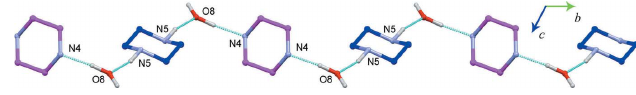
Figure 4 Part of the crystal structure of (I) showing the molecular chain, formed by O8–H8 C (cid:3)(cid:3)(cid:3) N4 and N5—H5 A (cid:3)(cid:3)(cid:3) O8 hydrogen bonds, which propagates parallel to the b axis.